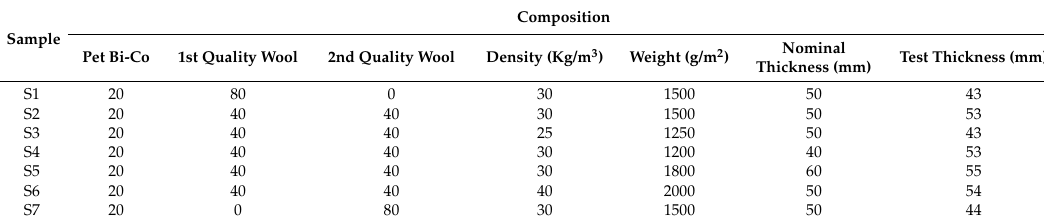
Table 2. Composition and the code used for each sample.